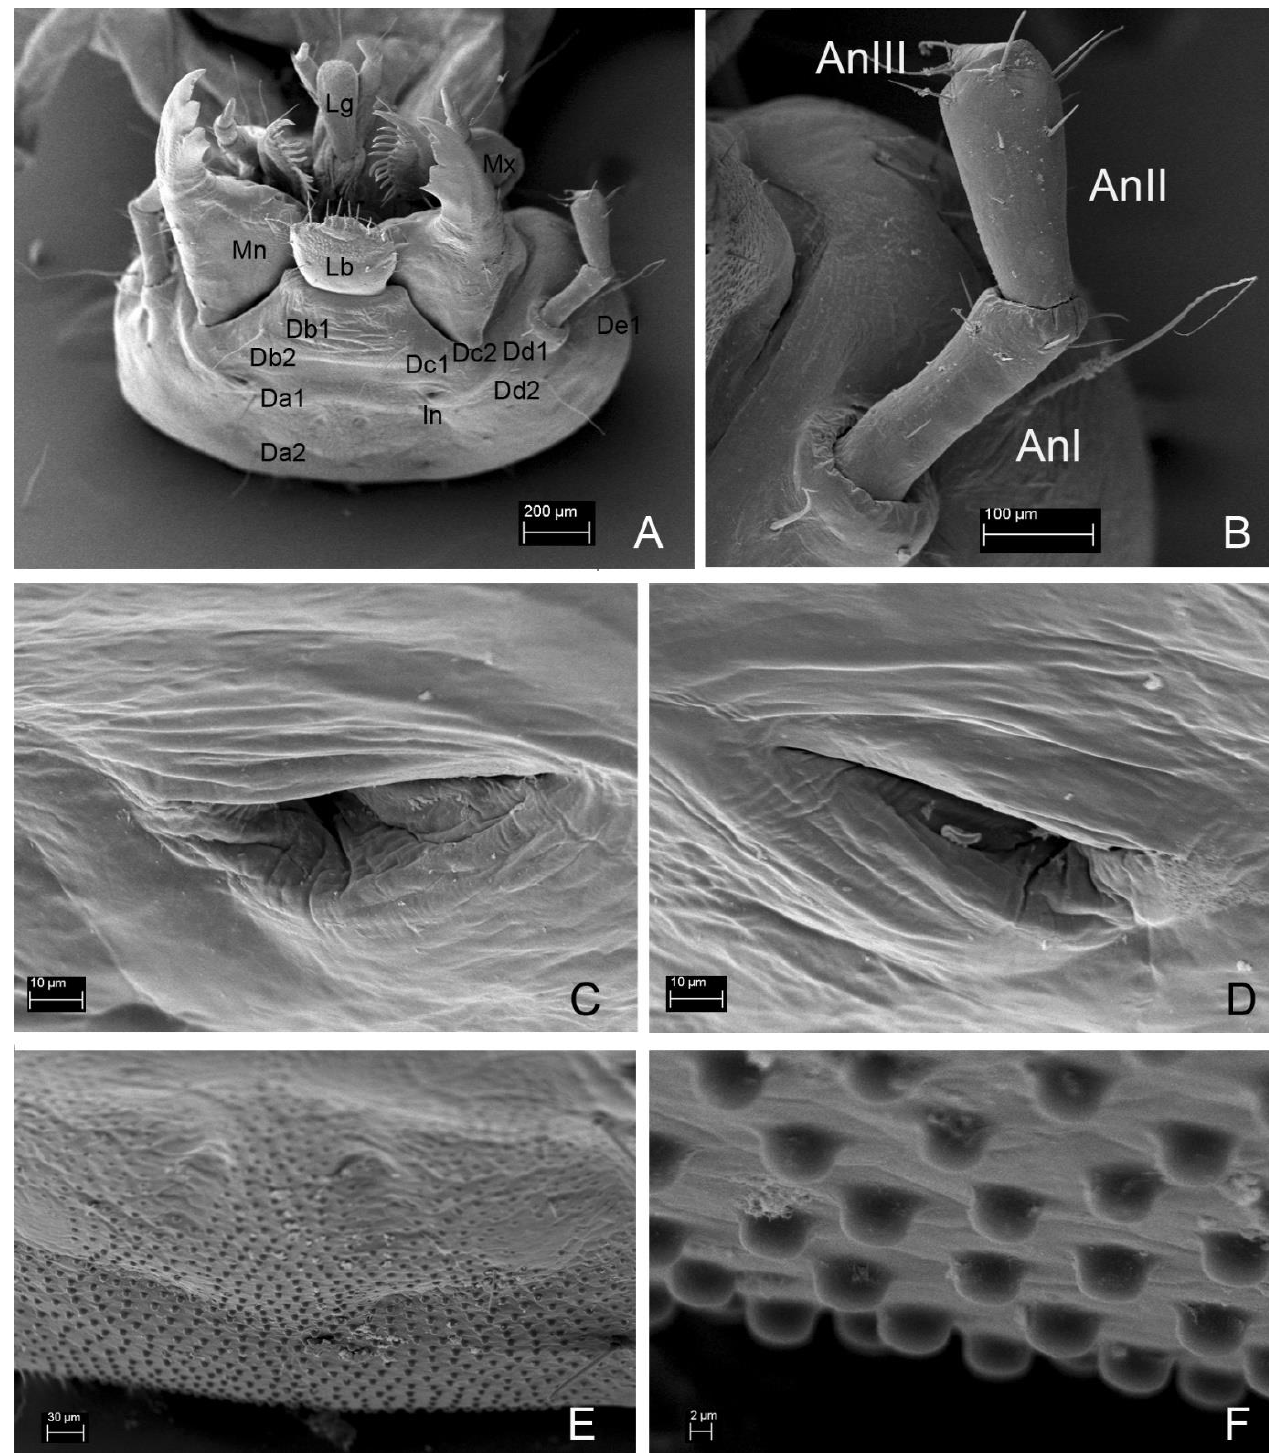
Figure 7. Leiodes cinnamomea . Details of larval morphology of instar III. ( A ) Head and mouthparts, dorso-apical view. ( B ) Antenna, dorsal side. ( C , D ) Invagination—pseudomycangia. ( E , F ) Granulation. Abbreviations: AnI, AnII, AnIII—antennomere I, II, III; L—labium; Lb—labrum; Lg— ligula; Mn—mandible; Lb—labrum. The other abbreviations refer to the terminology of setae.